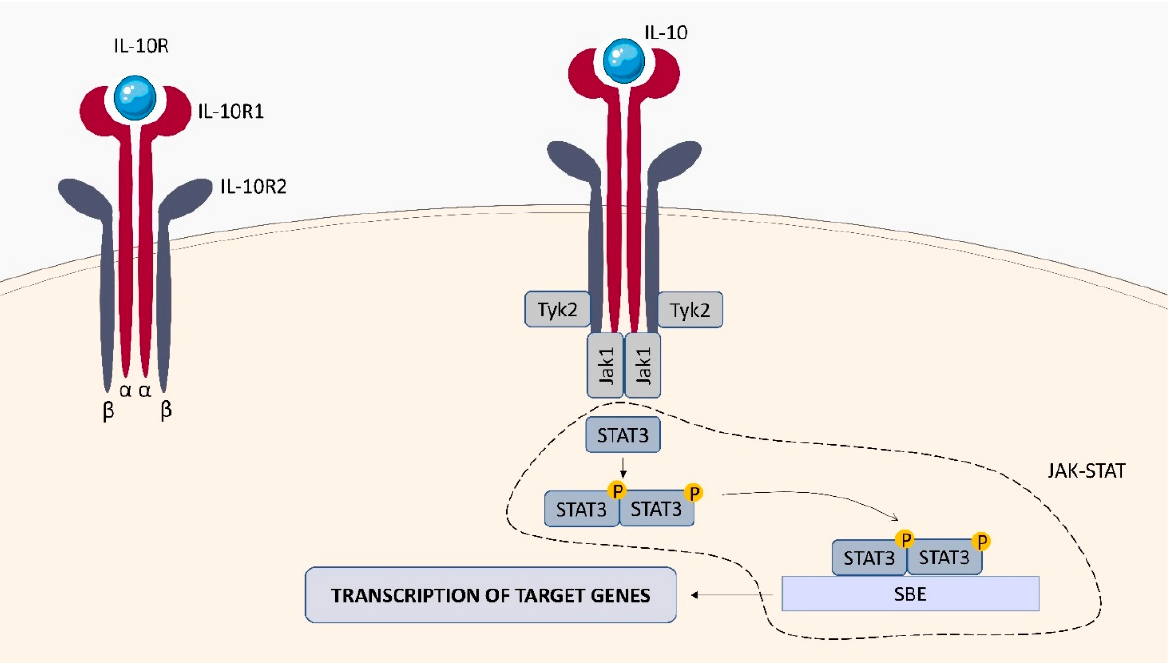
Figure 8. IL-10R structure and signaling. IL-10R consists of two β chains (IL-10R2) and two α chains (IL-10R1). The interaction of IL-10 with IL-10R activates the JAK1/TYK2 tyrosine kinases. The JAK-STAT pathway is activated, which stimulates the transcription of genes in the cell nucleus, leading to the production of cytokines.